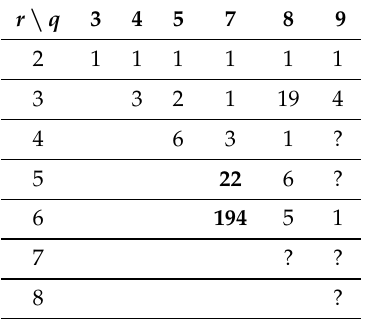
Table 2. The number of inequivalent ( m r ( 2, q ) , r )